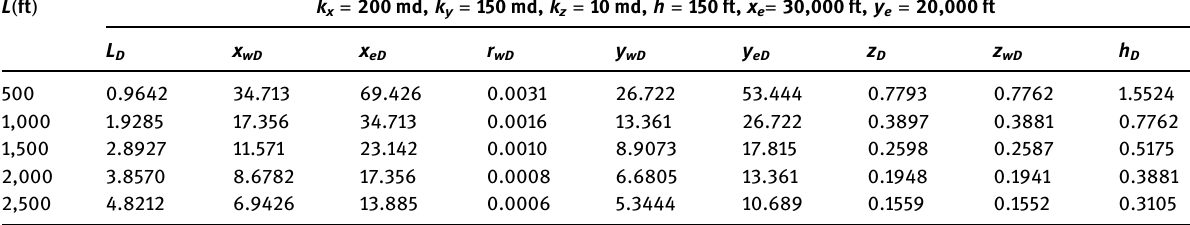
Table A1: Dimensional and dimensionless parameters for varying L D